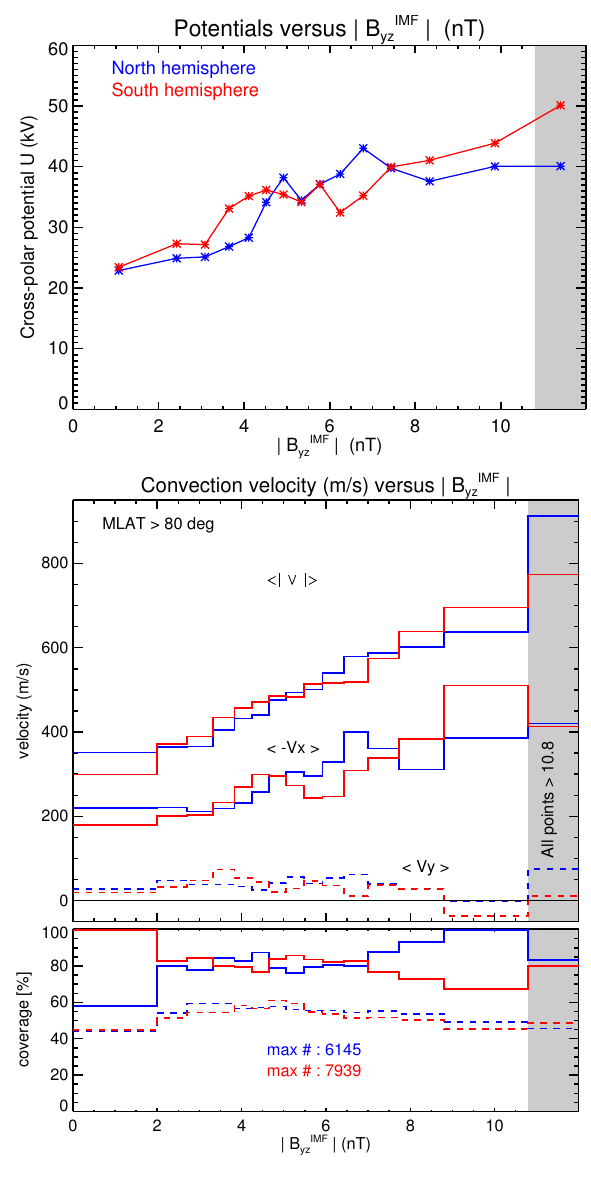
Fig. 8. Top: Polar cap potentials derived from the full high-latitude convection pattern for each bin as a function of | B IMF yz | for the Northern (blue) and the Southern Hemisphere (red). Middle panel: Average velocities as a function of the IMF magnitude | B IMF yz | within the central polar cap at magnetic latitudes | φ m | > 80 ◦ only. Lower panel: coverage for each bin as explained in Fig. 7, except that we now used variable bin widths so that the amount of data points are about equal in each bin-step.